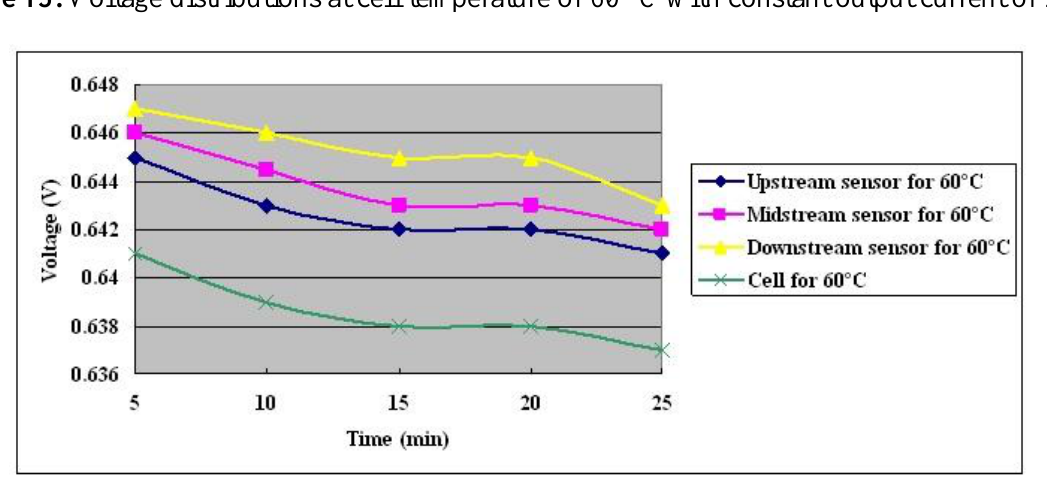
Figure 15. Voltage distributions at cell temperature of 60  C with constant output current of 25 A.